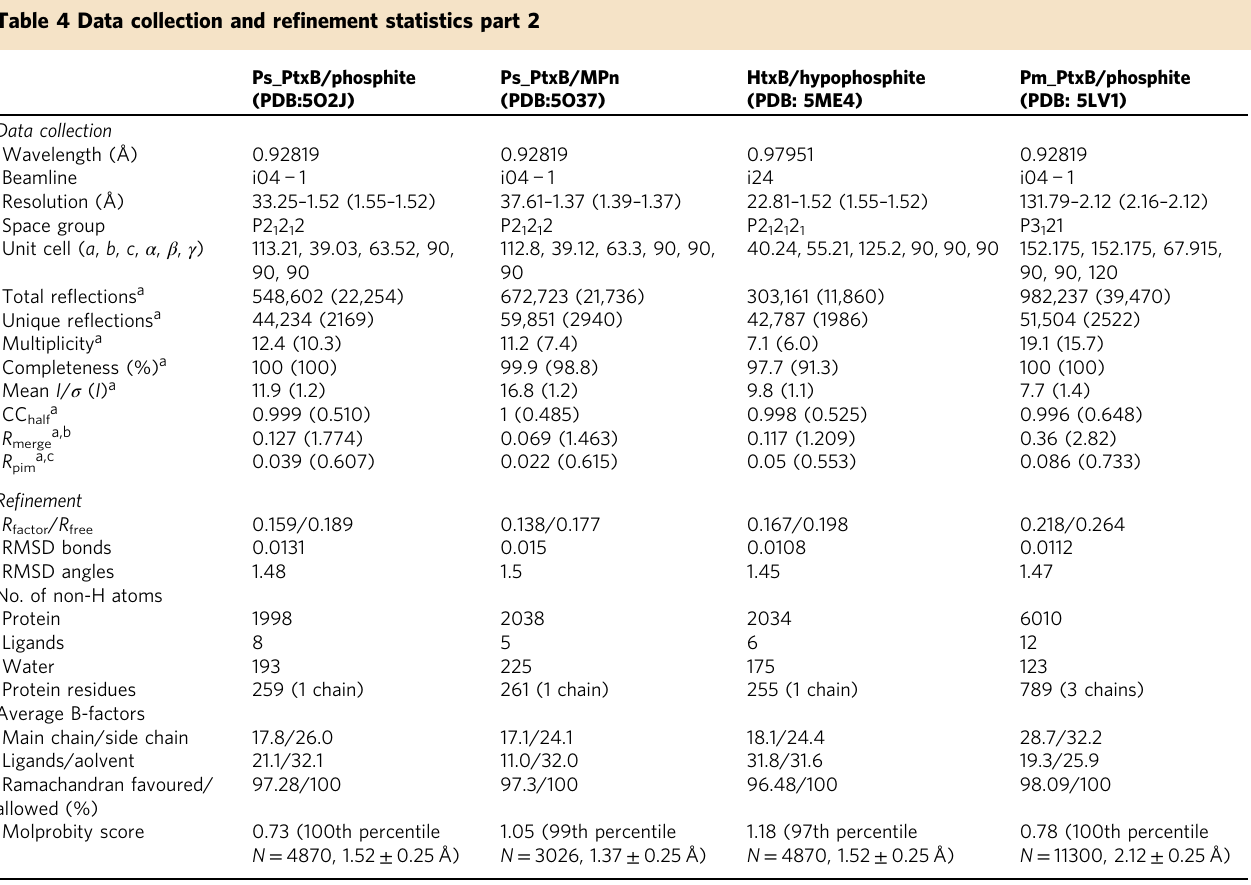
Table 4 Data collection and re fi nement statistics part